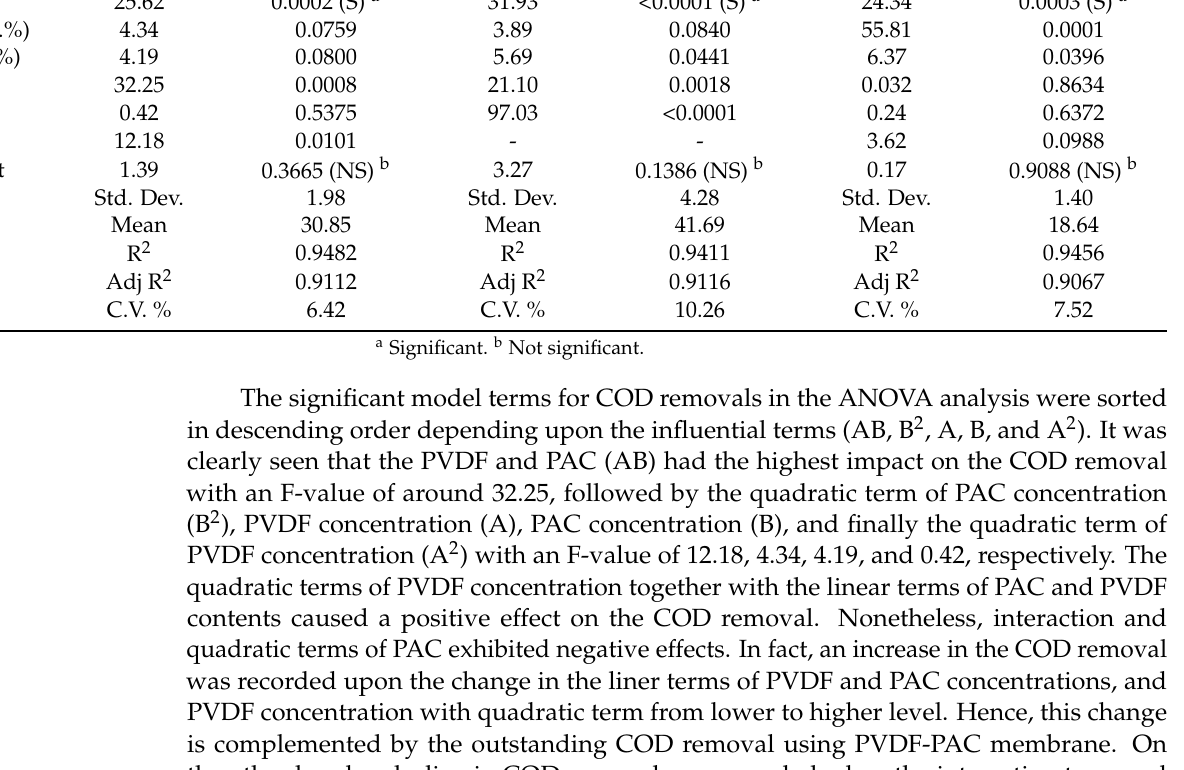
Table 3. ANOVA results and quadratic models of PVDF-PAC membranes for COD, colour, and NH 3 -N removal efficiencies. COD Removal Source